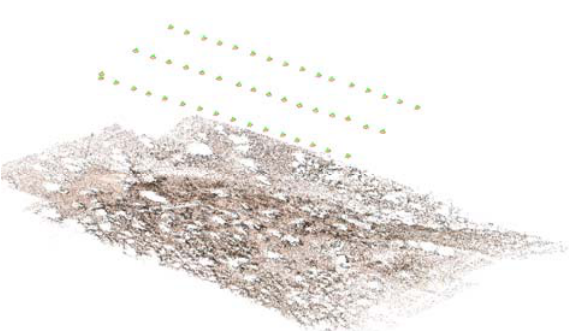
Figure 5. Camera orientations of the executed flight and 3D sparse model.